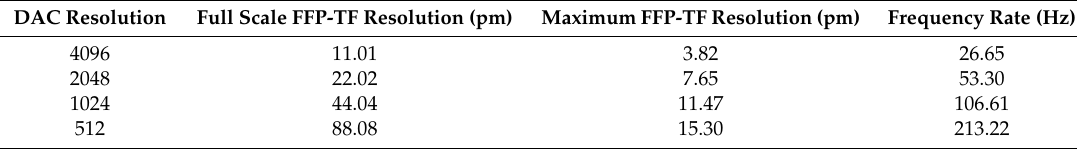
Table 1. Comparison Between Resolution and Frequency Rate.